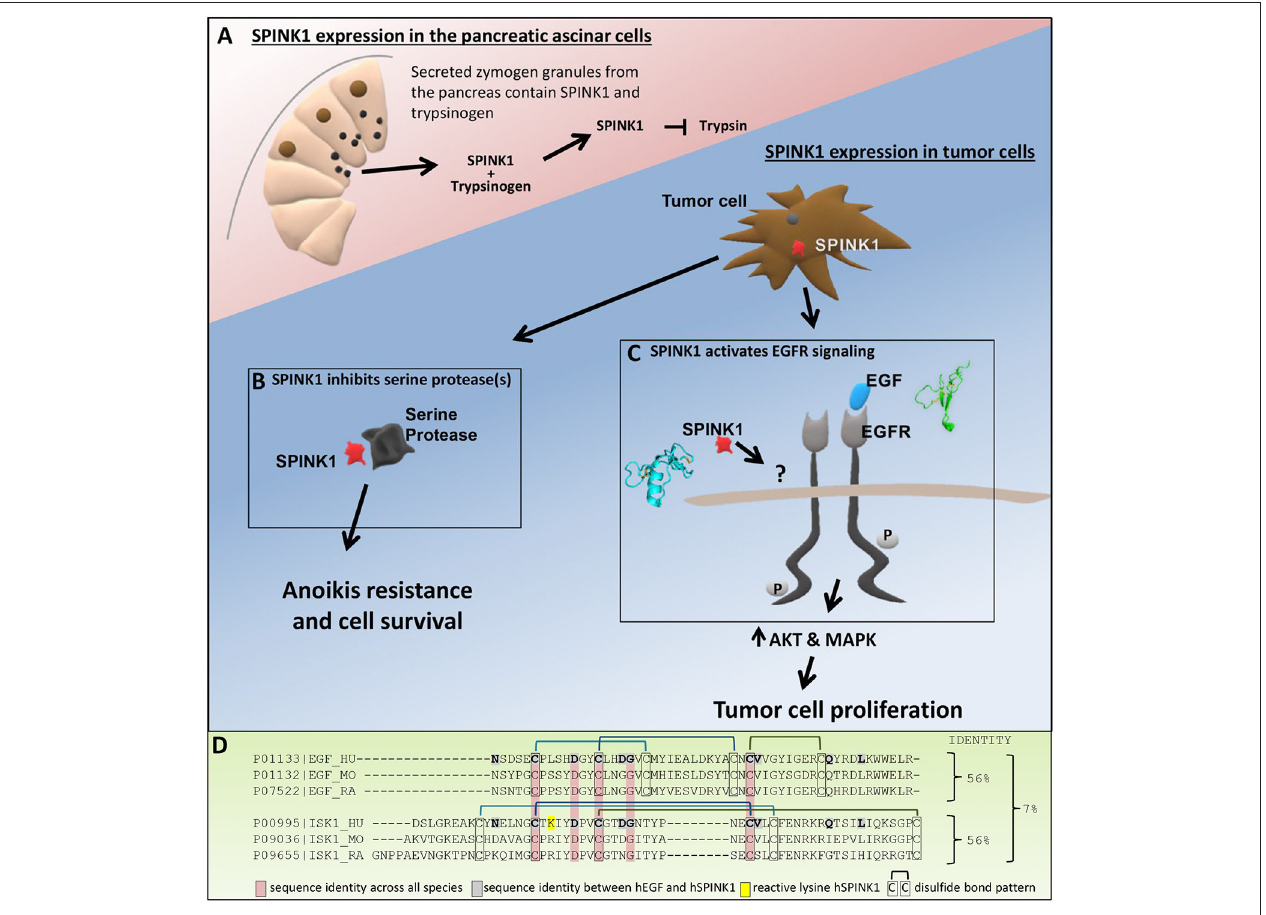
FIGURE 1 | Roles of SPINK1. (A) In the pancreas, SPINK1 acts as an important regulator of protease activity. SPINK1 is co-expressed with trypsinogen by the pancreatic acinar cells and secreted from zymogen granules into the pancreatic duct. Within the acinar cells or the duct, SPINK1 quenches prematurely activated trypsin to prevent further protease activation and organ damage. (B) Tumor cell secreted SPINK1 inhibits unknown serine protease(s) to induce anoikis resistance, tumor cell survival and metastatic disease. (C) Tumor cell secreted SPINK1 activates EGFR kinase pathways and leads to tumor cell proliferation; the direct receptor of SPINK1 in this context requires further definition. (D) Sequence alignment using Clustal Omega comparing human, mouse, and rat EGF with human, mouse, and rat SPINK1 (ISK1) homologs. Identified are sequence identity between hEGF and hSPINK1, sequence identities across all three species, and disulfide bond